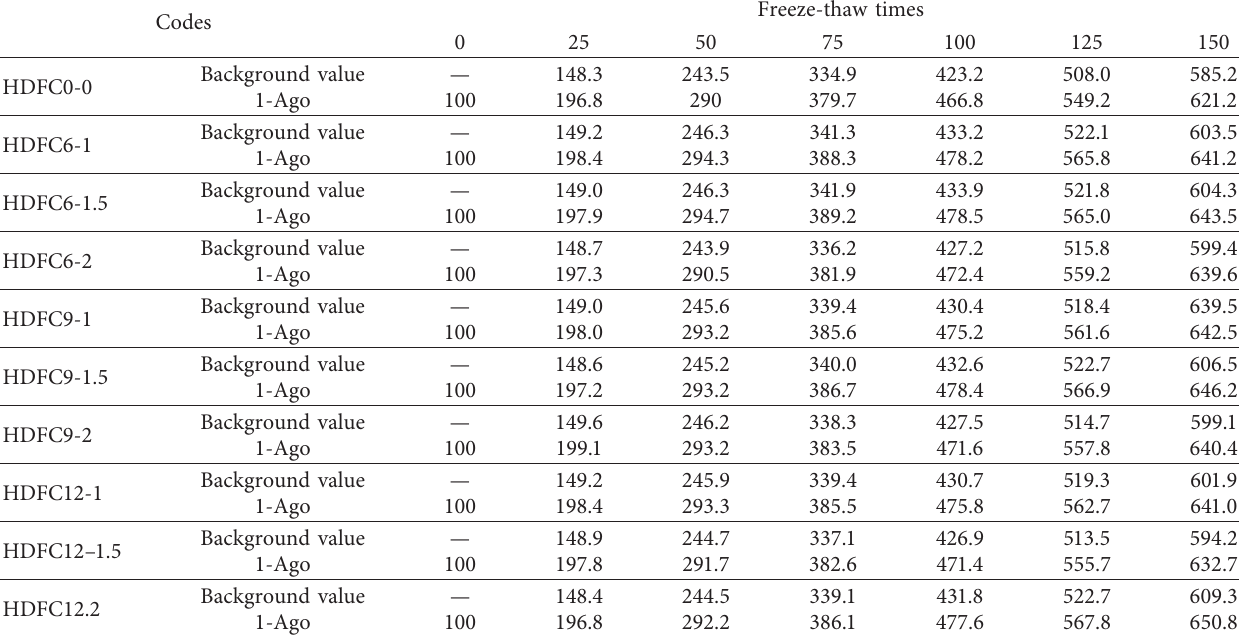
Table 6: The background value of the relative dynamic elastic modulus of HDFC is 1-AGO.